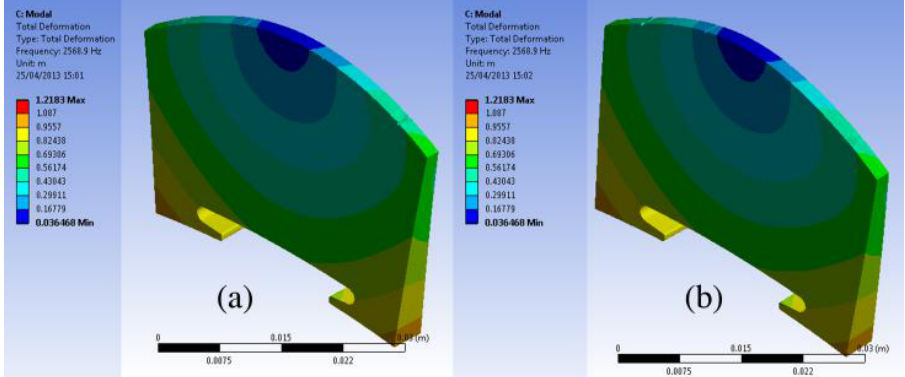
Figure 12. Bridge motion of the resonance mode at 2,569 Hz in Table 4. Note that we attach no significance to the amplitude of the